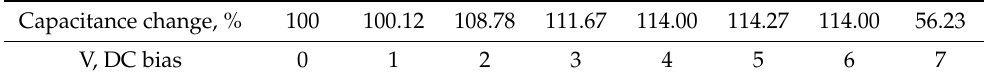
Table 2. KZM100-Y2O3 capacitance change with DC bias.